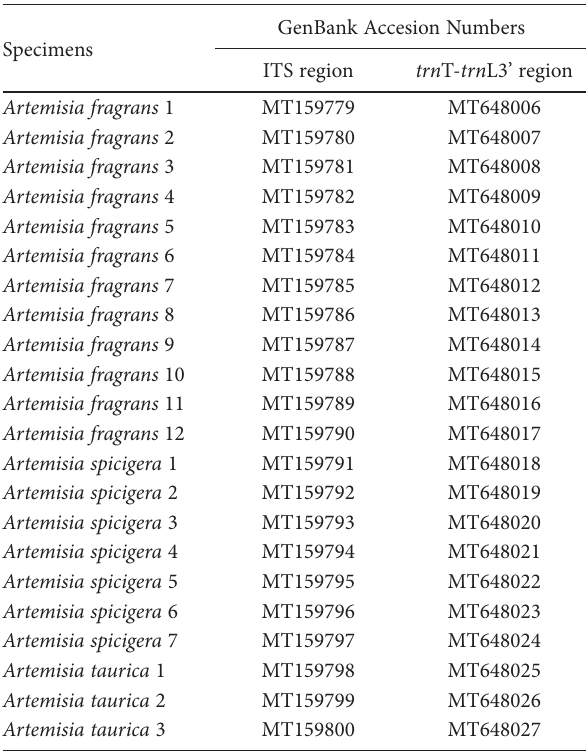
Table 4. GenBank accession numbers for the rDNA ITS (ITS1-5.8S- ITS2) and trn T- trn L3’ regions of the studied